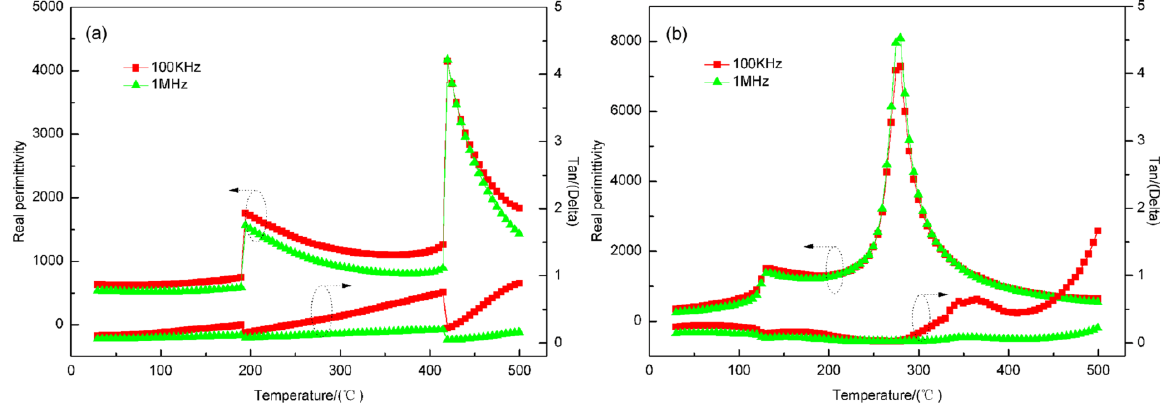
Na )NbO -LiNbO 0.5 0.5 3 3